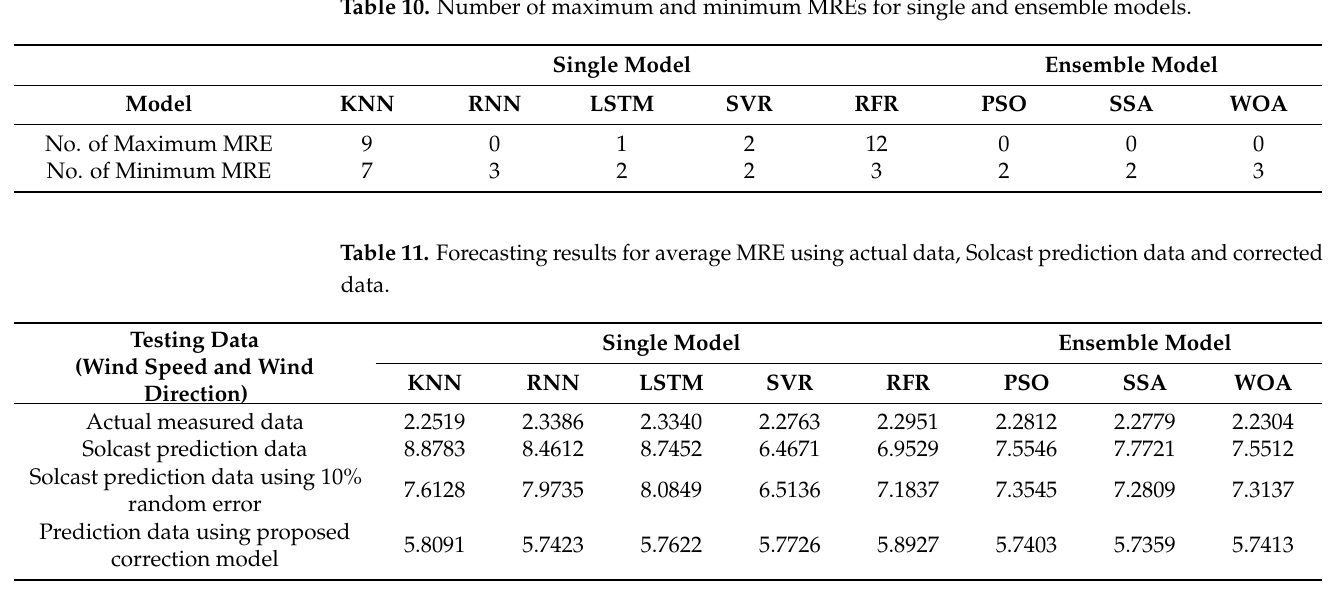
Table 10. Number of maximum and minimum MREs for single and ensemble models.